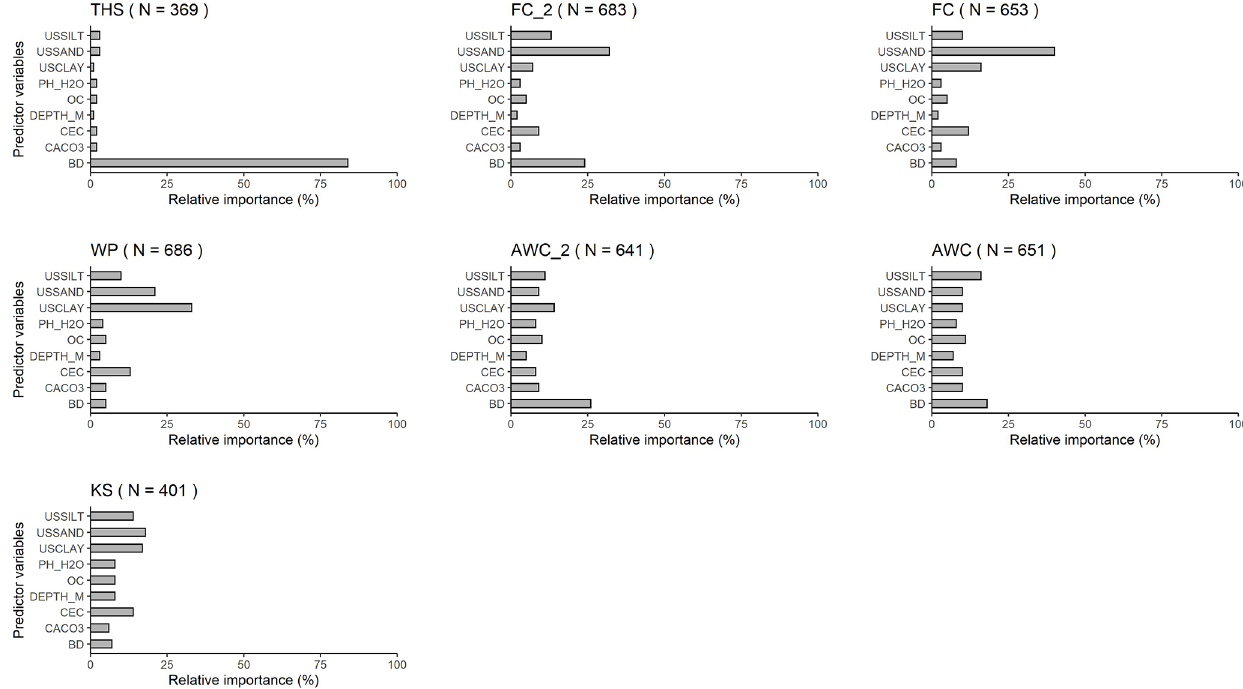
Figure 3. Relative variable importance computed with the random forest algorithm for the prediction of water content with PTF32 at saturation (THS), at field capacity; − 100 (FC_2) and − 330 (FC) matric potential head, at wilting point (WP), of the plant available water content based on FC_2 (AWC_2) and FC (AWC), and the saturated hydraulic conductivity (KS). USSILT: silt content (2–50µm (mass%)); USSAND: sand content (50–2000µm (mass%)); USCLAY: clay content ( < 2µm (mass%)); PH_H2O: pH in water (–); OC: organic carbon content (mass%); DEPTH_M: mean soil depth (cm); OC: organic carbon content (mass%); CEC: cation exchange capacity (cmol( + )kg − 1 ); CACO3: calcium carbonate content (mass%); BD: bulk density (gcm − 3